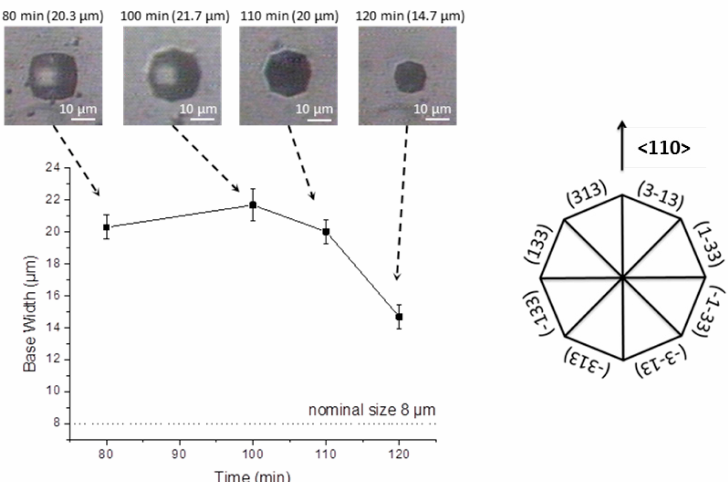
Figure 6. Top view microscopic images demonstrating the evolution of base width, upon the wet etch process, obtained from a 8 μm × 8 μm square mask with a spacing of 40 μm, after IPA evaporation. This process occurred first as described in Figure 5 (up to 80 min), but with an increased spacing as to prevent merging, followed by etching in solution without IPA (after 80 min).